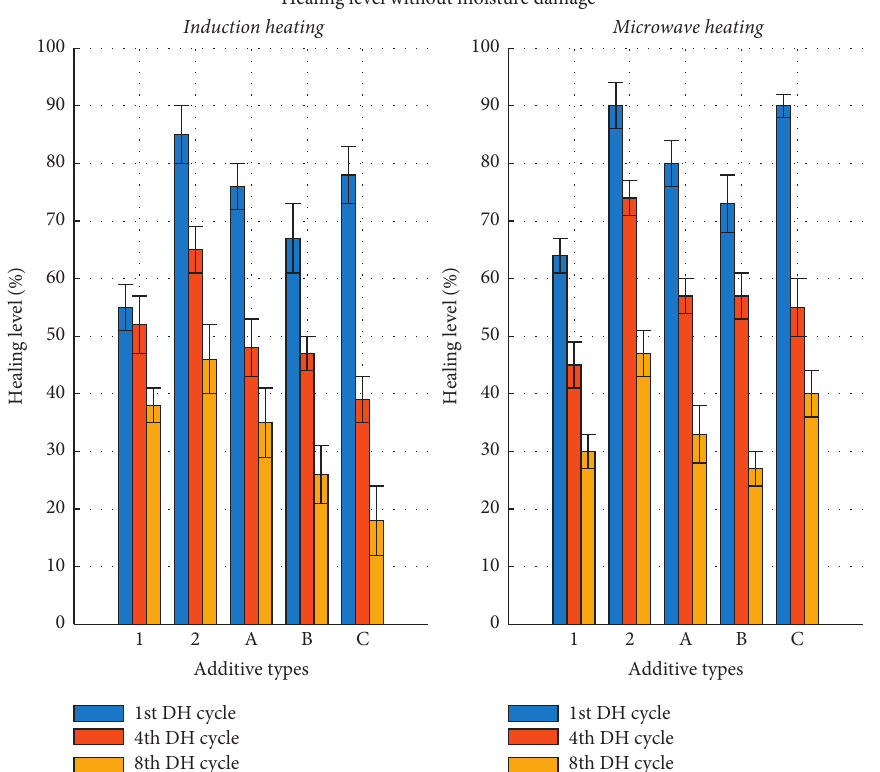
Figure 8: Healing level of unaged mixtures without moisture